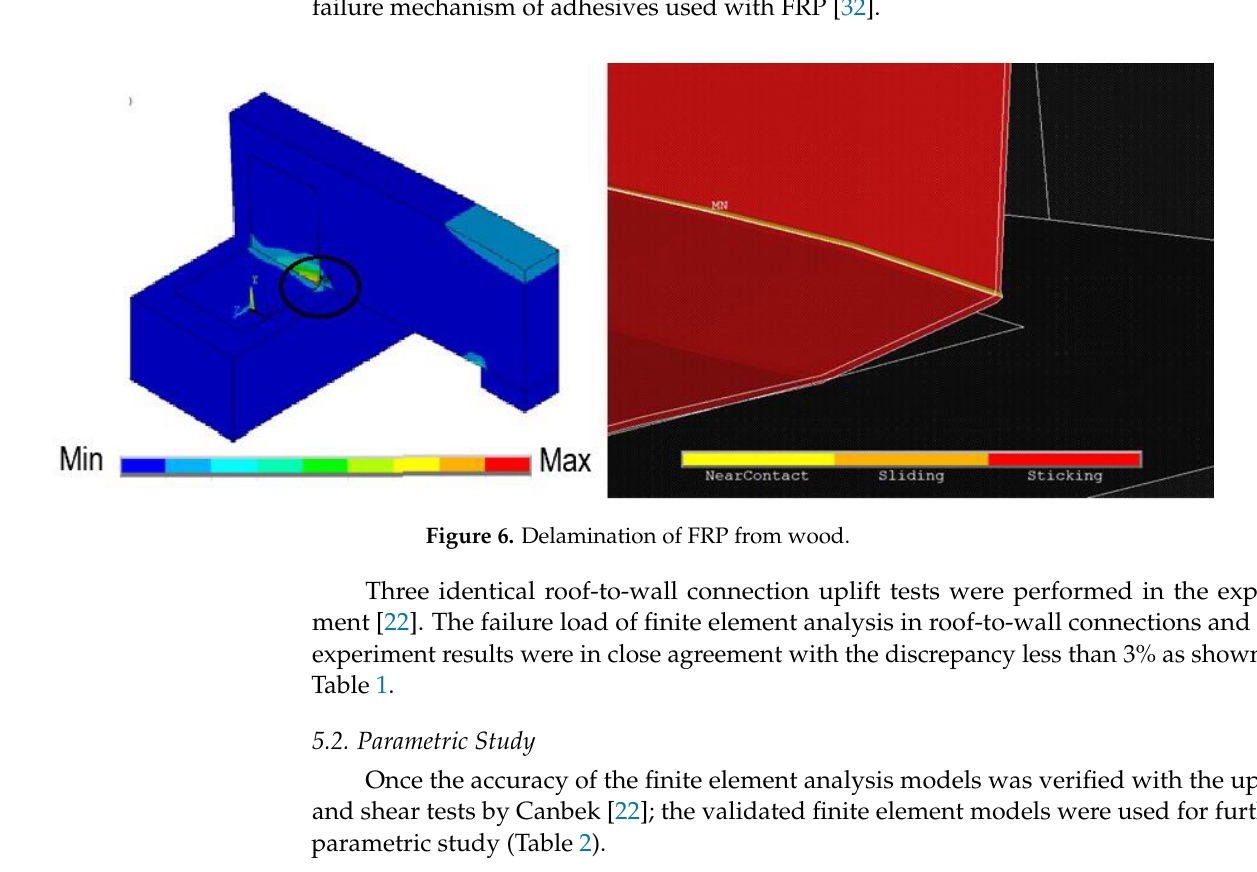
Table 2. Parameters under